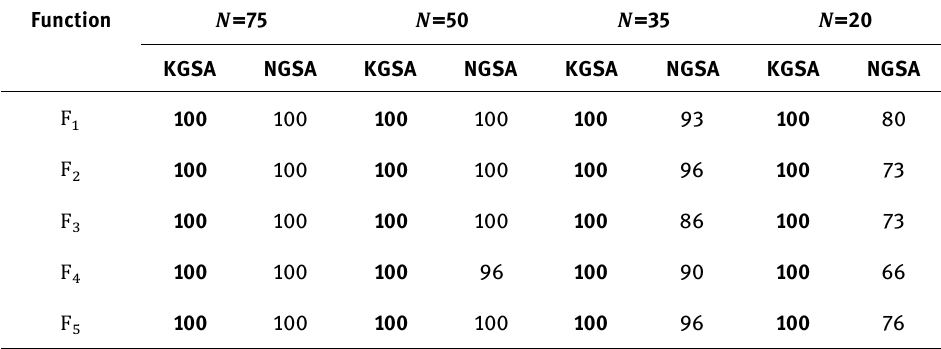
Table 3: %ADR obtained with the KGSA and NGSA using different population sizes, and uniform initialization for finding all local and global maxima.